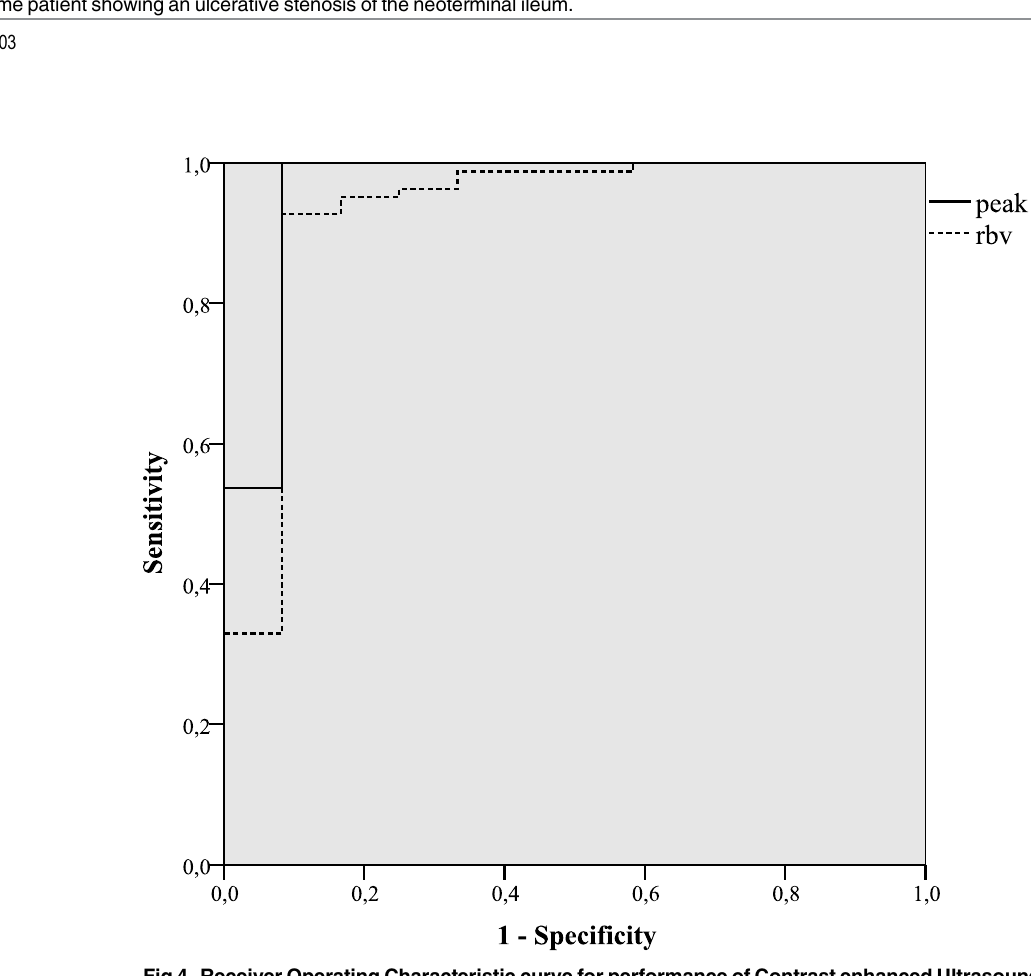
PLOS ONE | DOI:10.1371/journal.pone.0136105 August 31,